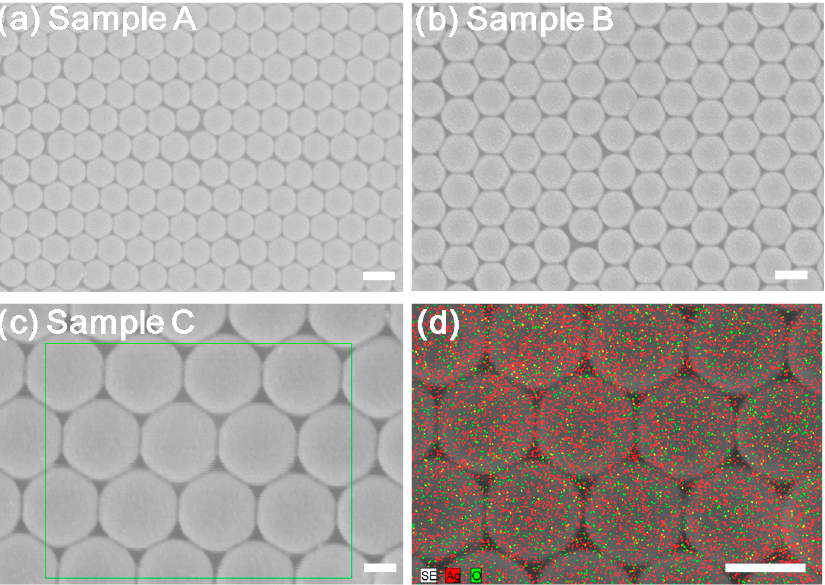
Figure 3. FESEM images of PS CPhC structures with 4.5 wt %, AgNPs: ( a ) sample A; ( b ) sample B; ( c ) sample C. ( d ) EDS compositional mapping (Ag/O overlay) scans from the red dashed line area of image (c). All scale bars are 200 nm.